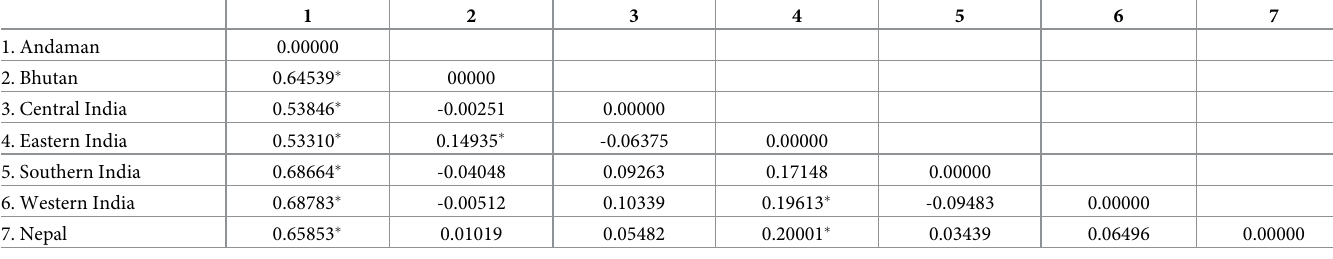
� indicates p value � 0.05.